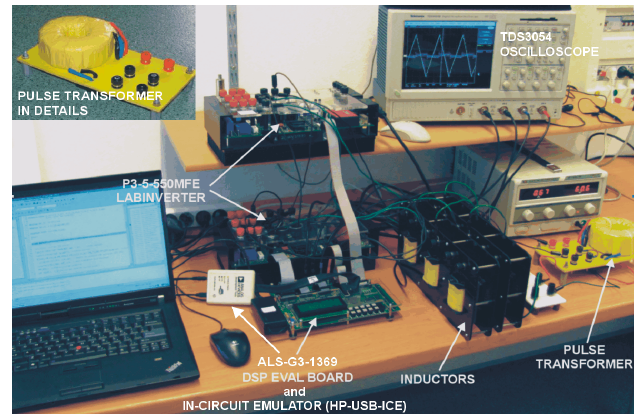
Figure 14. View of the laboratory stand during tests.